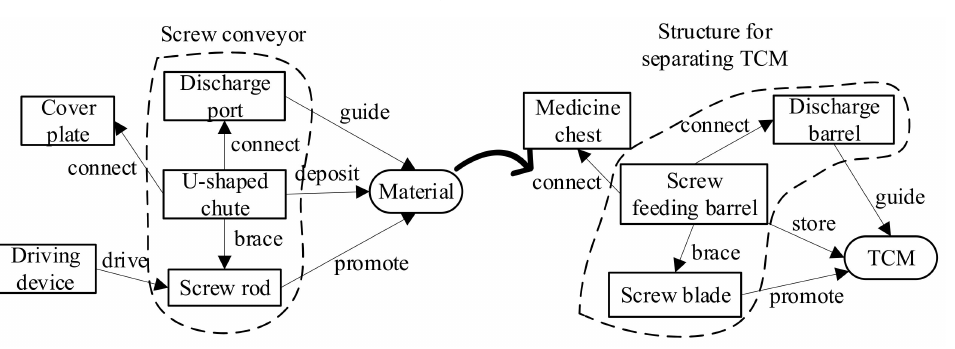
Figure 22. Analogy process of screw conveyor.